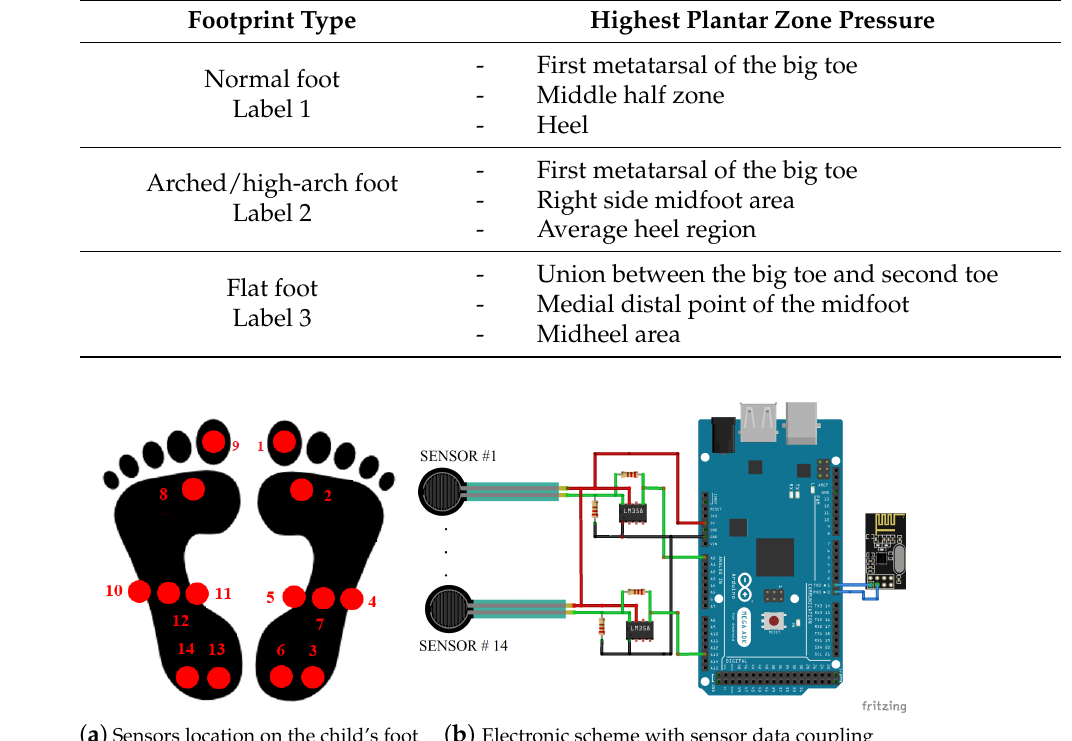
Table 1. Highest plantar zone pressure by footprint type.